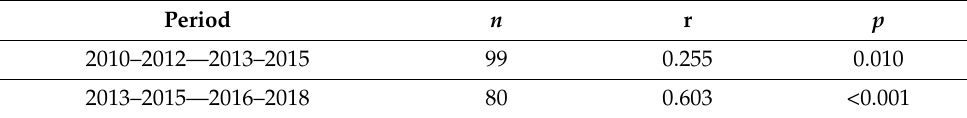
Table 3. Correlation between the HSRRs in each consecutive period (3-year analysis).